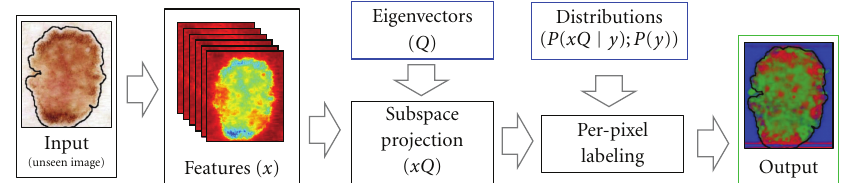
Figure 3: The testing phase of our per-pixel (PP) model. Features are computed as in the training phase. The projection Q is used to transform the features into the subspace determined in the training phase. Maximum a-posteriori estimation, using the posteriors estimated in the training phase, is then used to generate the